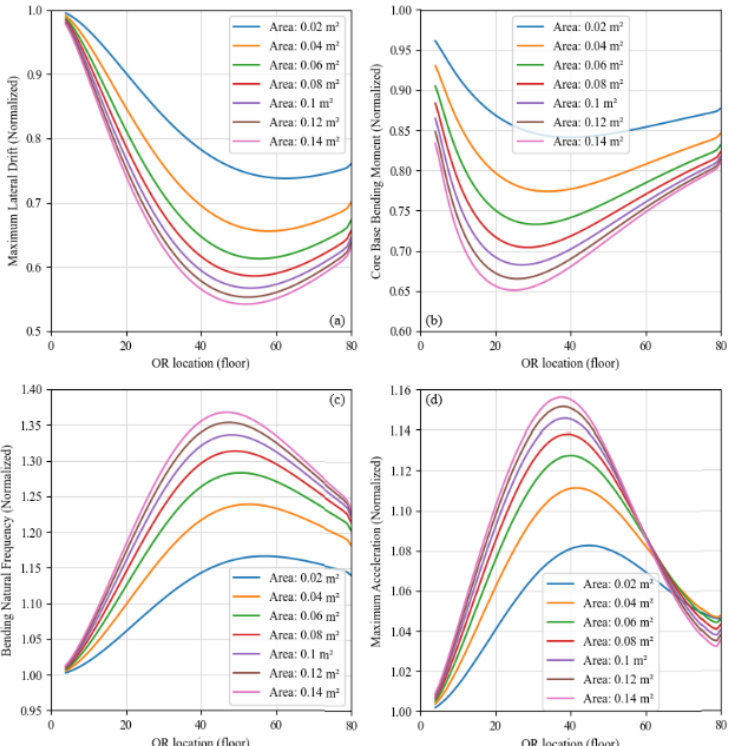
Figure 5. Influence of the OR area in relation to the optimum floor to (a) MLD (b) CBM (c) Bending nat. freq. (d) Max.